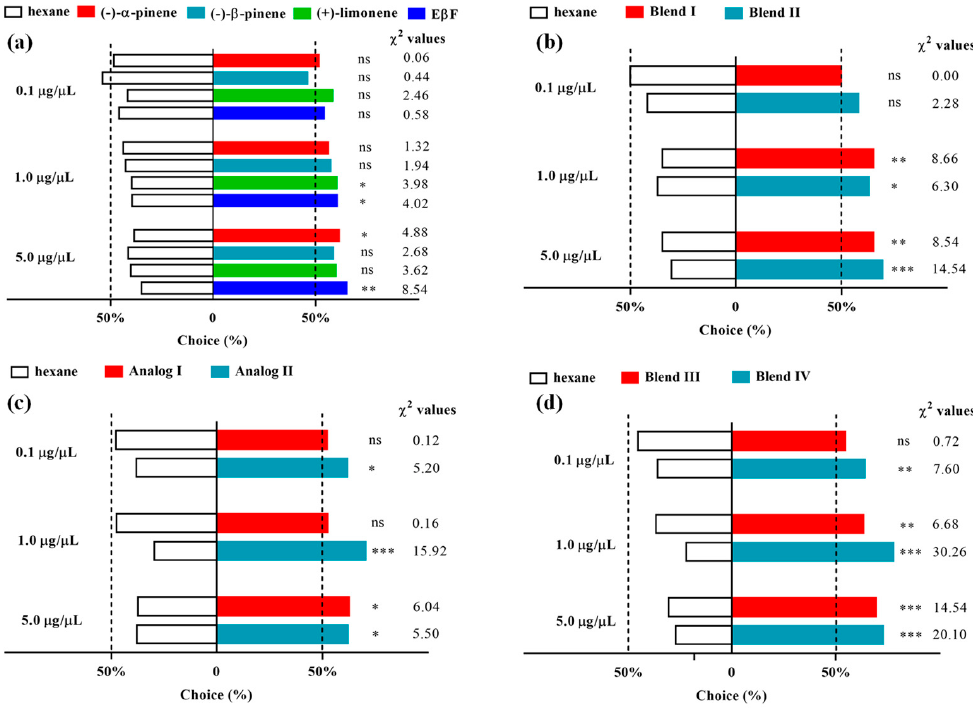
Figure 2. Behavioral response of Diaeretiella rapae to single and blend components of aphid alarm pheromone and analogs. ( a ) Response of D. rapae to single components of aphid alarm pheromone. ( b ) Response of D. rapae to blend components of aphid alarm pheromone. ( c ) Response of D. rapae to single components of analogs. ( d ) Response of D. rapae to blend components of E β F and analogs. (ns = no significant difference; p > 0.05; * p < 0.05; ** p < 0.01; *** p < 0.001).